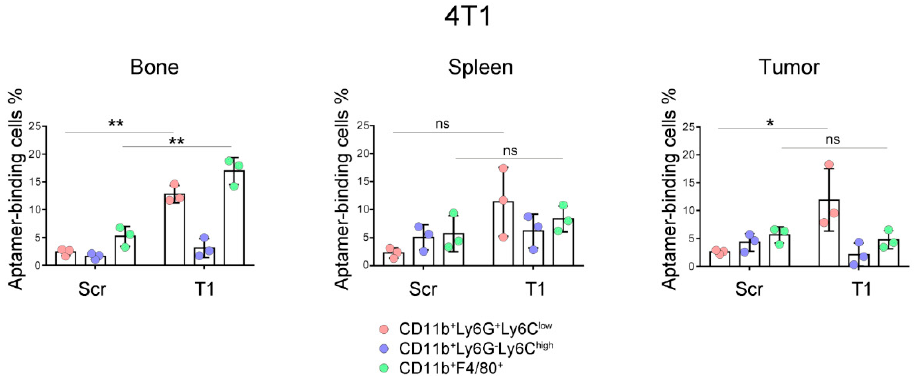
Figure 2. Analysis of aptamer-binding myeloid cells in murine model of primary 4T1 mammary gland tumor. Mice bearing primary 4T1 tumors ( n = 3 mice/group) were treated with Cy5-labeled T1 or scramble aptamer. They were euthanized 4 h later, and single cells were prepared from bone marrow, spleen and tumor. Flow cytometry was performed to detect aptamer-positive cells in the granulocytes, M-MDSC and macrophage populations. Pink: CD11b + Ly6C low Ly6G + granulocytes; Blue: CD11b + Ly6C high Ly6G - M-MDSCs; Green: CD11b + F4/80 + macrophages. Data is presented as mean ± s.d. P values are calculated with a two-tailed student t- test. *, p < 0.05; **, p < 0.01; ns, not significant.